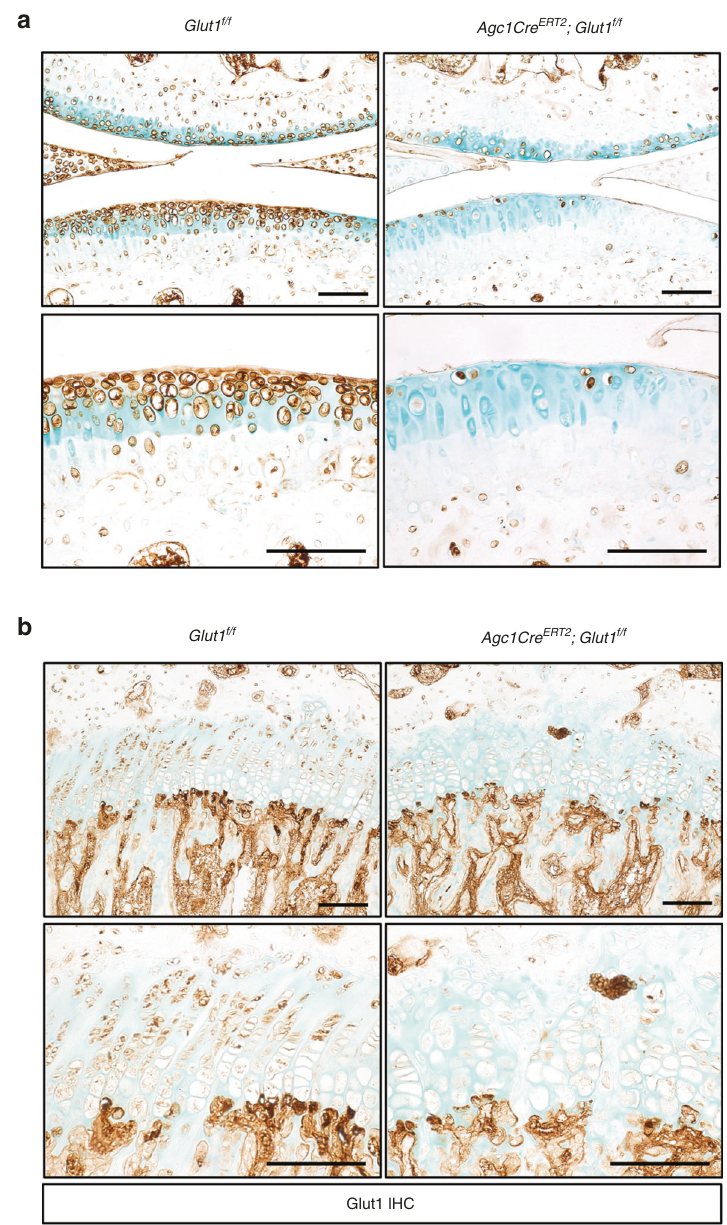
Fig. 2 Postnatal genetic deletion with Agc1CreERT2 eliminates Glut1 in both the growth plate (GP) and articular cartilage (AC) in mouse long bones. a – b Immunostaining for Glut1 AC in knee sections ( a ) and GP tibia sections ( b ) of Glut1 f/f (control; Con) and Agc1Cre ERT2 ;Glut1 f/f (Glut1 LOF; Mut) mice 1 month following tamoxifen induction. N = 3. Scale bar, 100 μ